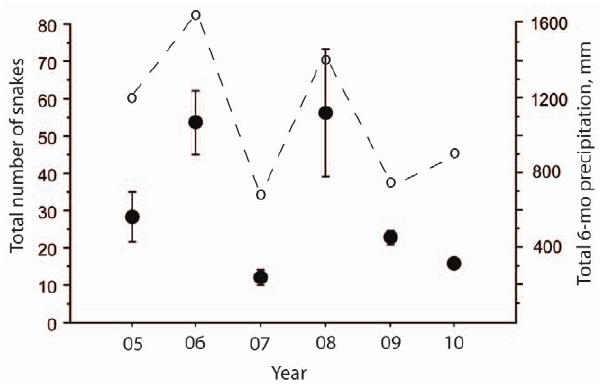
Figure 2. Year-to-year variation in the mean number of snakes counted ( ± SE) and previous 6-mo precipitation during the six years of the study.